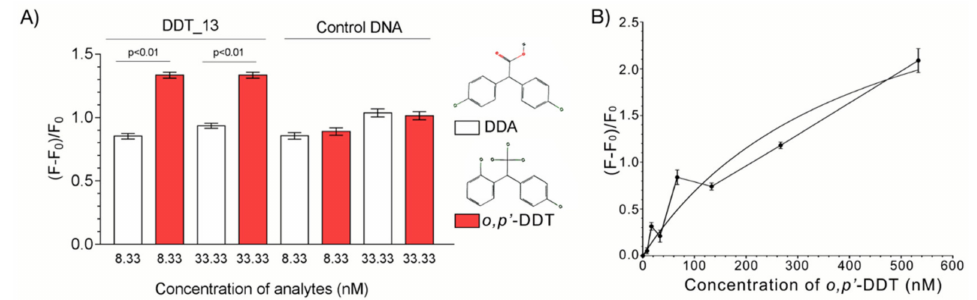
Figure 3. Binding tests between DDT_13 and its target o,p’ -DDT. ( A ) Fluorescence response to the DDT_13 and control DNA while adding with o,p’ -DDT and a interfering homologue molecule DDA; Insert images: the 2D structure of o,p’ -DDT and DDA; ( B ) Determination of the dissociation constant (Kd) of DDT_13.